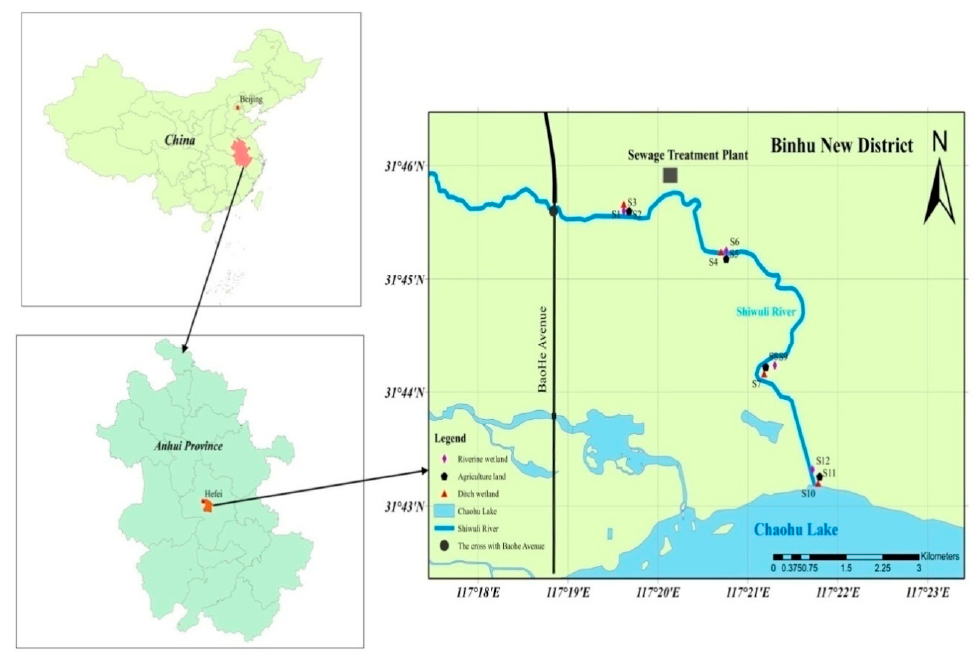
Figure 1. Sampling sites and regional context. Table 1. Main properties of the sediments/soils of the Shiwuli River.